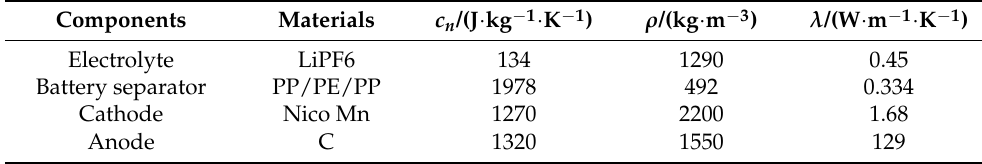
Table 2. Thermophysical parameters of